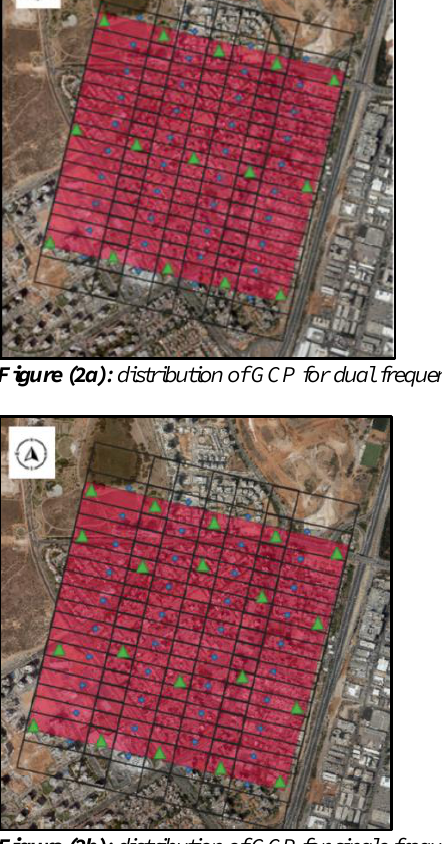
Figure (2b) : distribution of GCP for single frequency